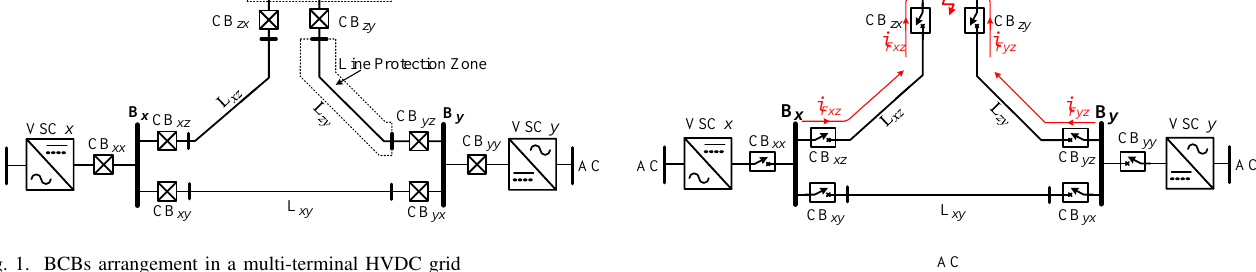
currents i Fxz and i Fyz flow through the adjacent lines to the fault location and are in the backward directions of CB zx and CB zy and cannot be interrupted by